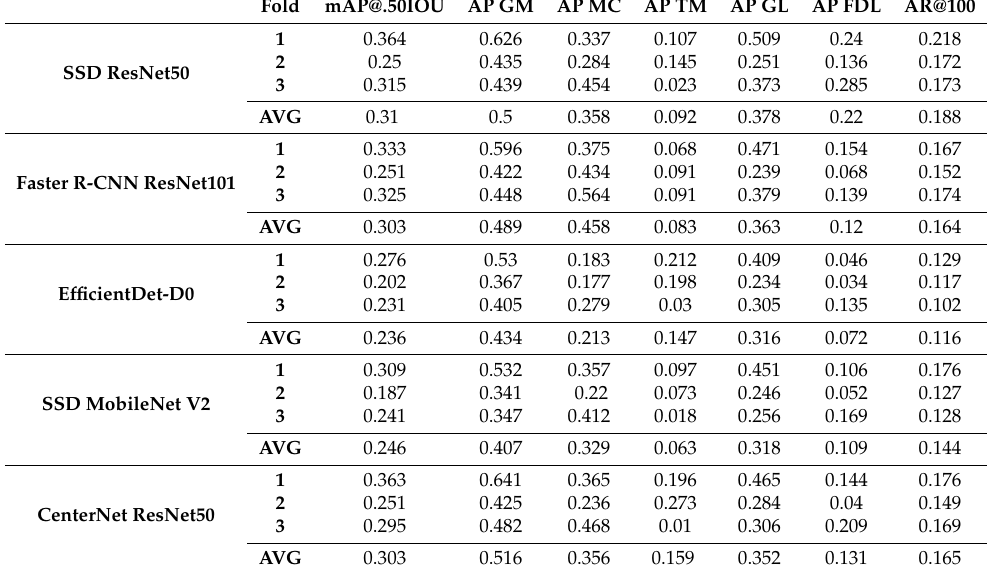
Table 2. Model-centric results for 3-fold cross-validation.